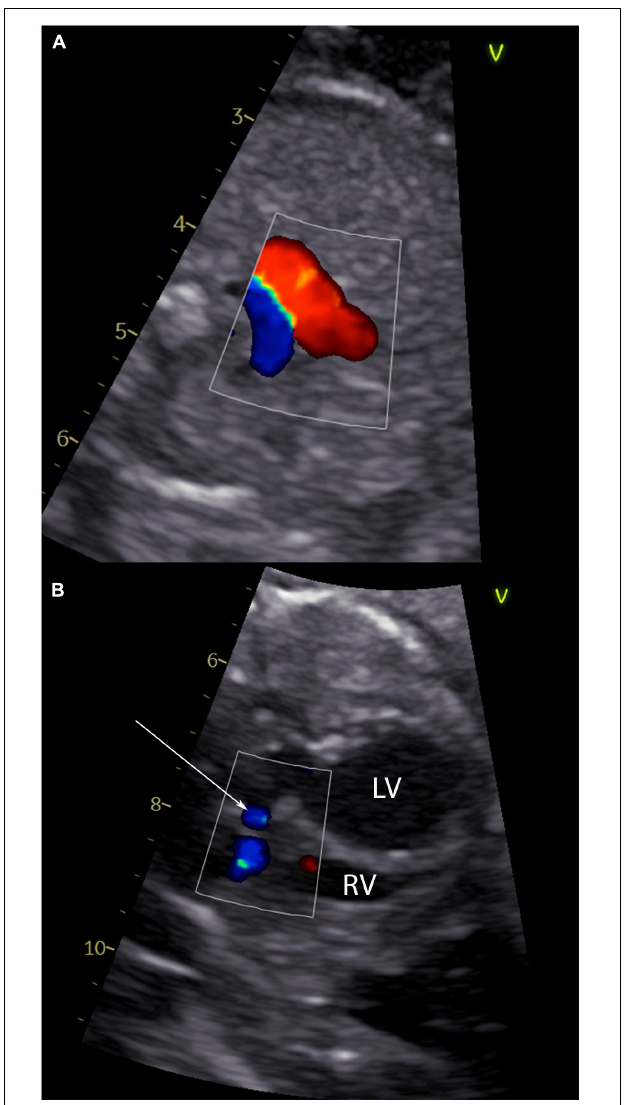
FIGURE 2 | Echocardiographic signs of an evolving hypoplastic left heart syndrome. Panel (A) shows a 3-vessel view of a fetus with critical aortic stenosis with antegrade flow in the ductus arteriosus Botalli (red flow) and retrograde flow in the aortic arch (blue flow). In panel (B) left to right shunting at the atrial level of the same fetus is shown